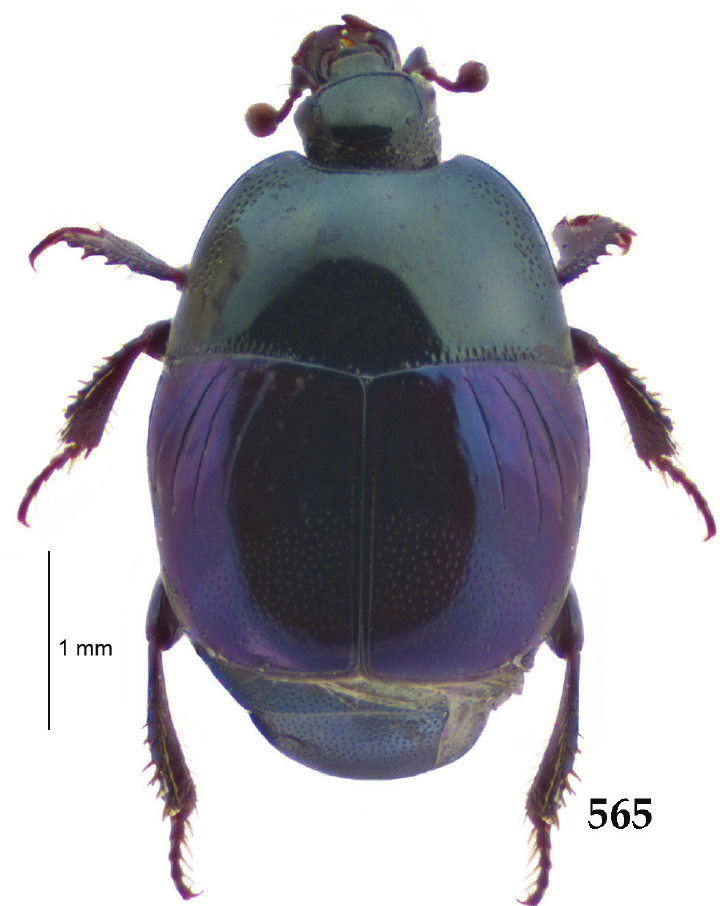
Figure 565. Saprinus ( Saprinus ) tyrrhenus Blackburn, 1903 habitus, dorsal view.